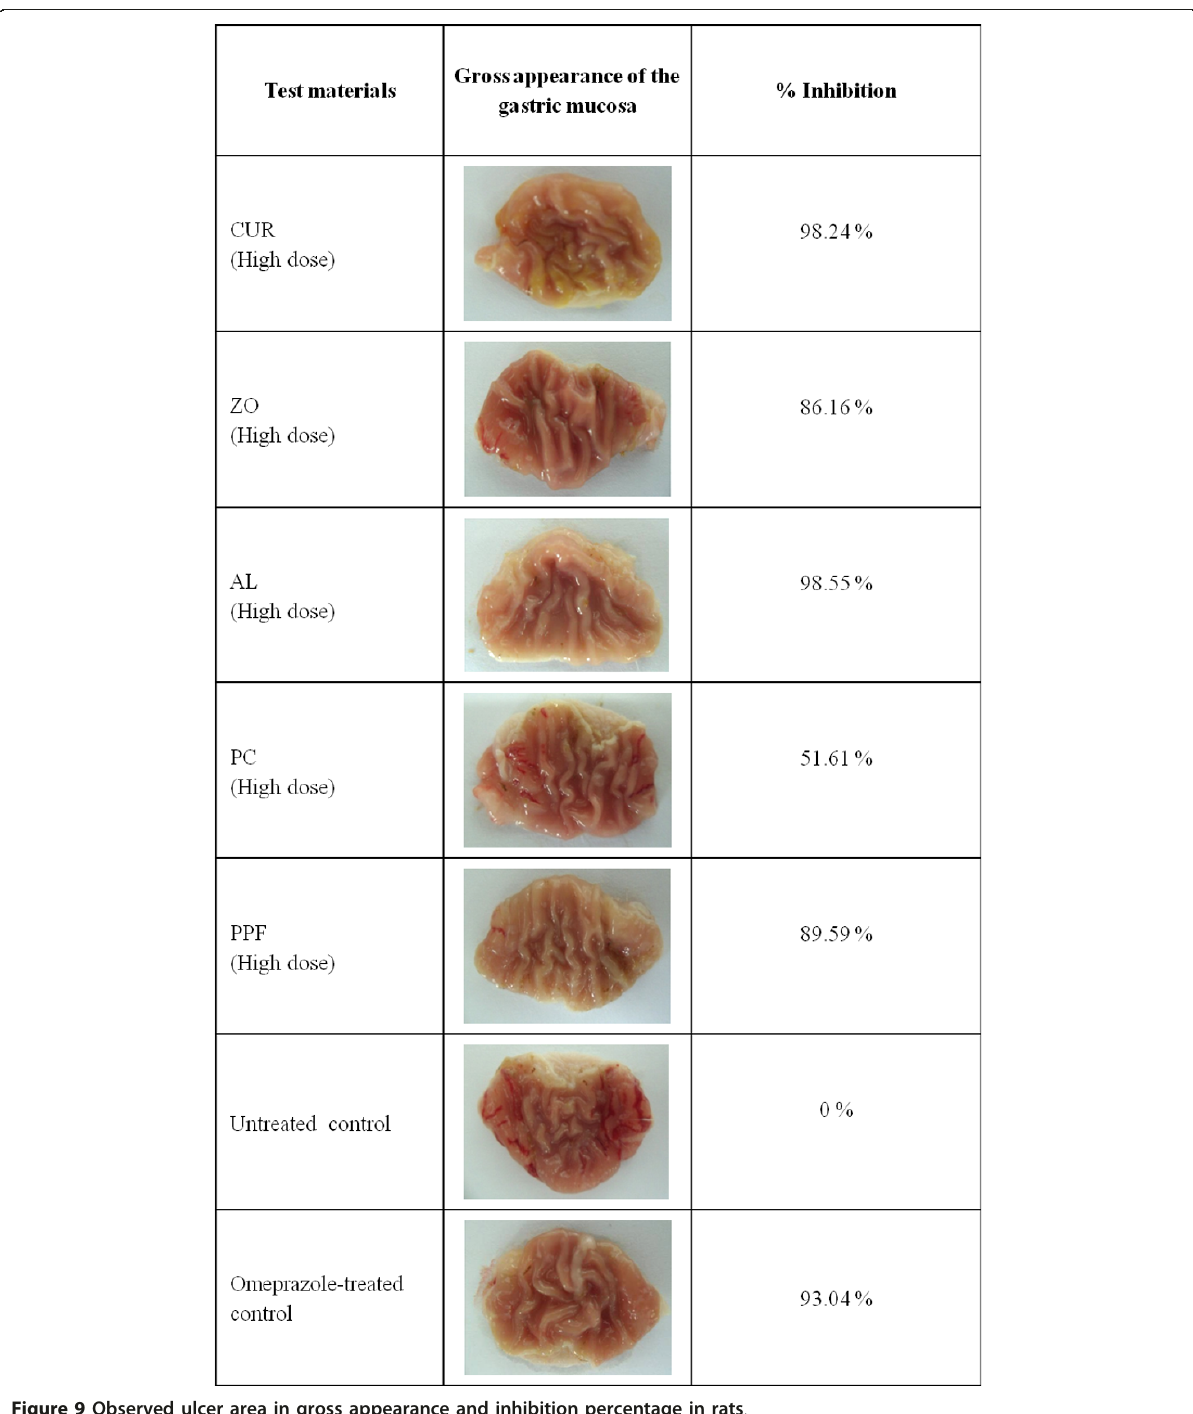
Autopsy and histopathological examination For both toxicity and anticancer activity evaluation, all internal organs were removed from the animals at autopsy and observed macroscopically. Samples were